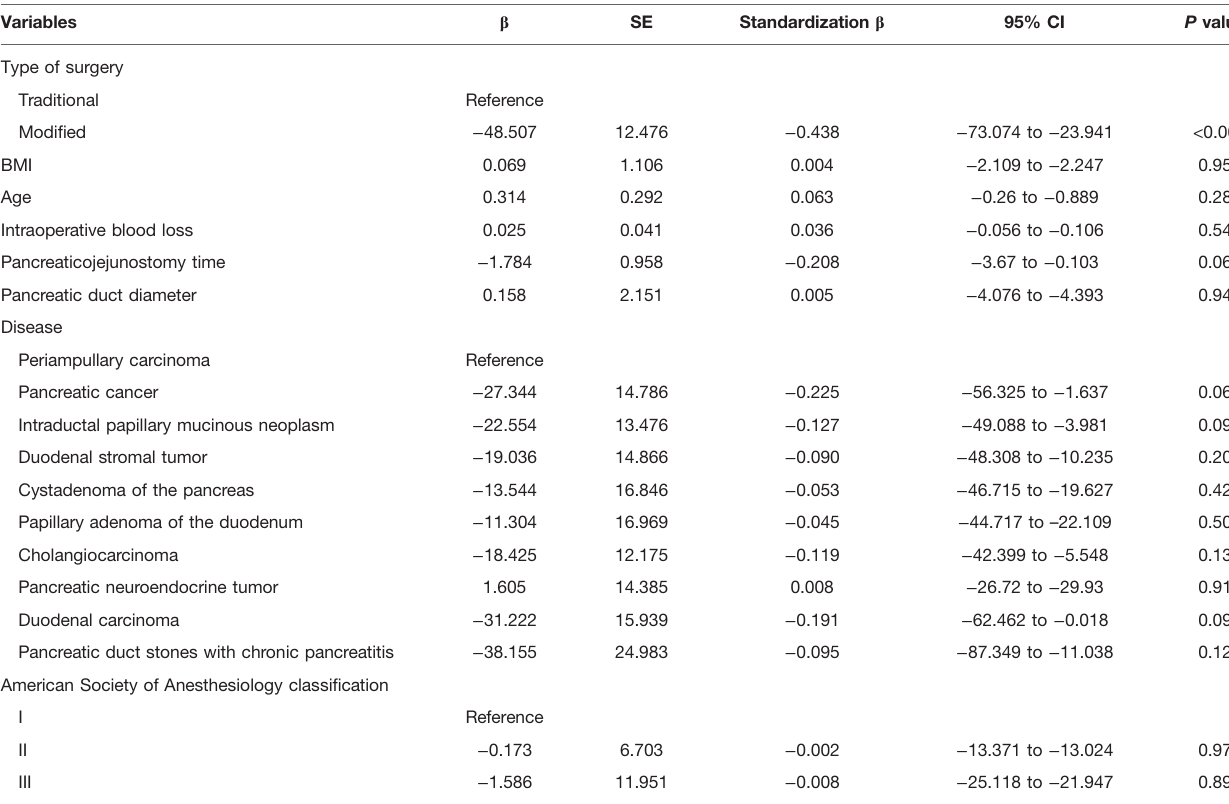
TABLE 3 | Independent factors affecting operation